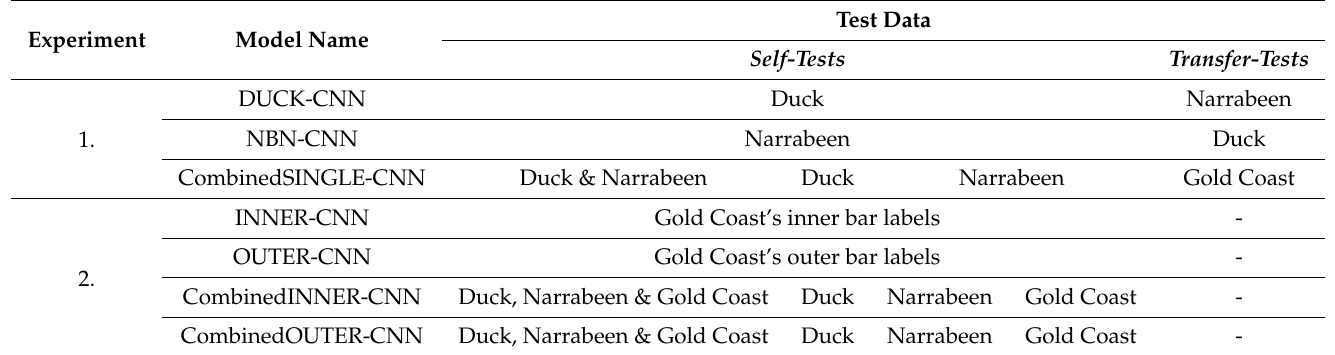
Table 5. The two experiments, the corresponding models and the data combinations on which the models were